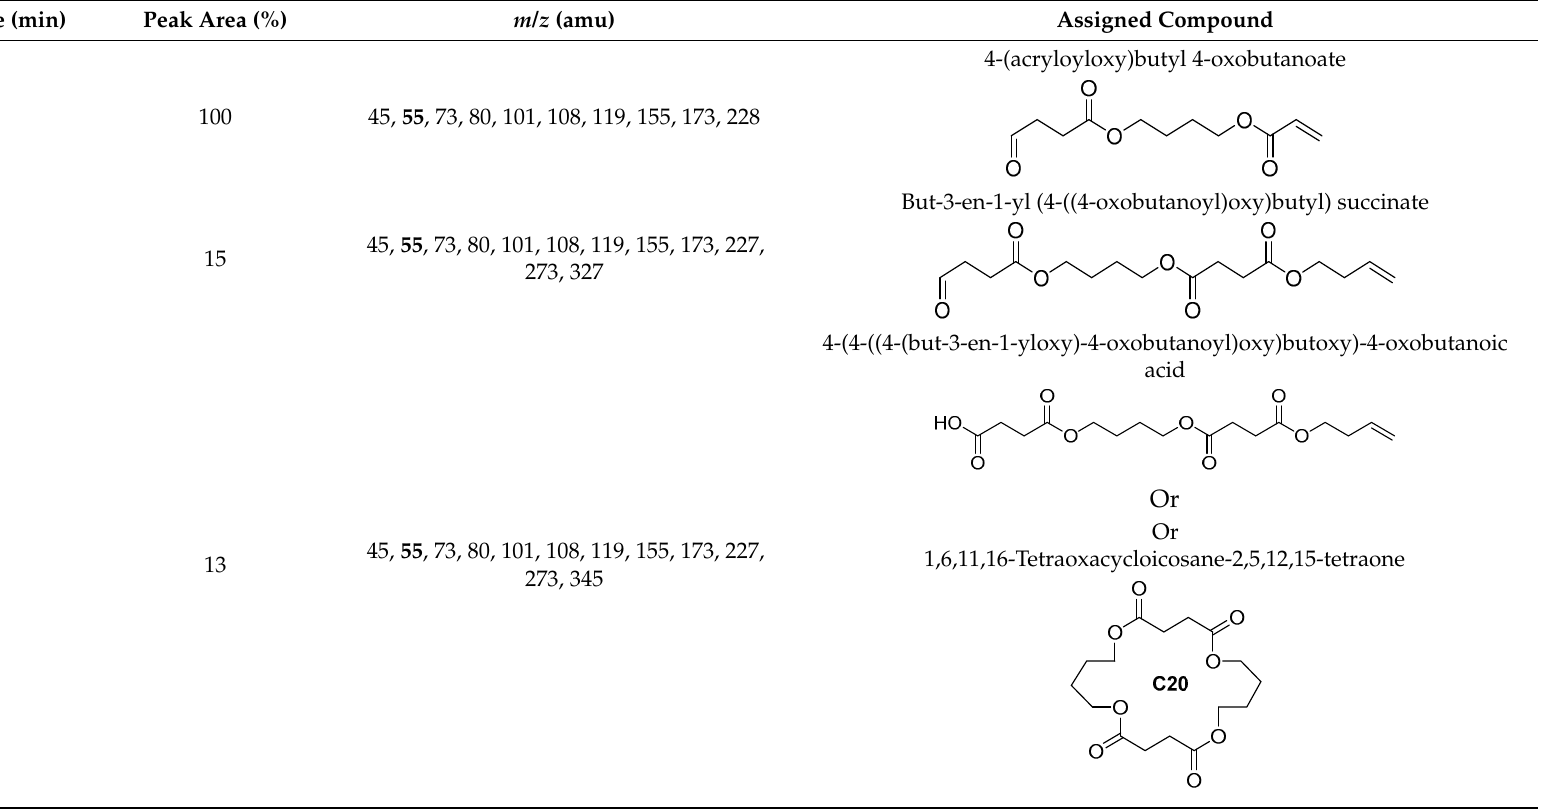
Figure 4. Mass spectra of major decomposition products of PBSu. Table 5. Thermal decomposition products of PHSu. Peak Name m/z